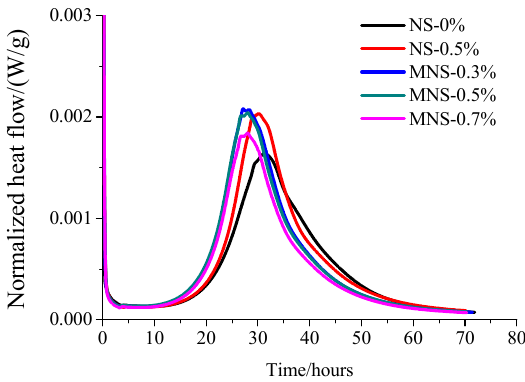
Figure 5. Heat evolution of HPCs with the addition of NS and MNS.